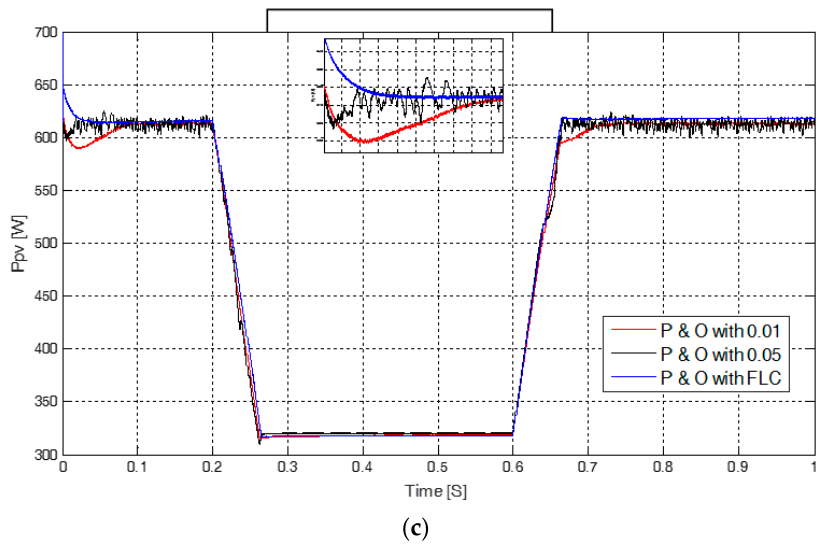
Figure 9. Steady-state and dynamic response comparison of the proposed fuzzy logic controller (FLC)-based P&O with the P&O algorithm with step of reference voltage of 0.05 and 0.01. ( a ) Changes of irradiation; ( b ) Variable Step of a Reference Voltage; ( c ) PV array output power.